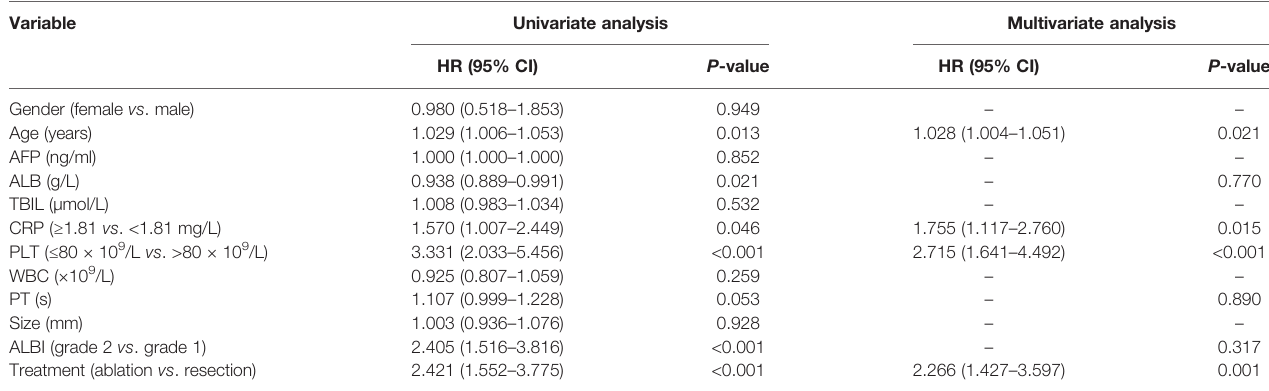
TABLE 2 | Univariate and multivariate analyses of time to recurrence beyond the Milan criteria (TRBM) in the entire cohort.